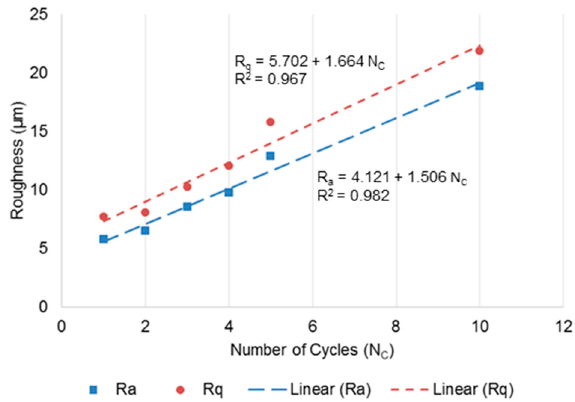
Figure 12. Pareto diagram for the significance of the effects of the variables in the DOE regarding R a ( a ) and R q ( b ). Variable D: number of cycles shows a relatively stronger significance than the others in both cases.